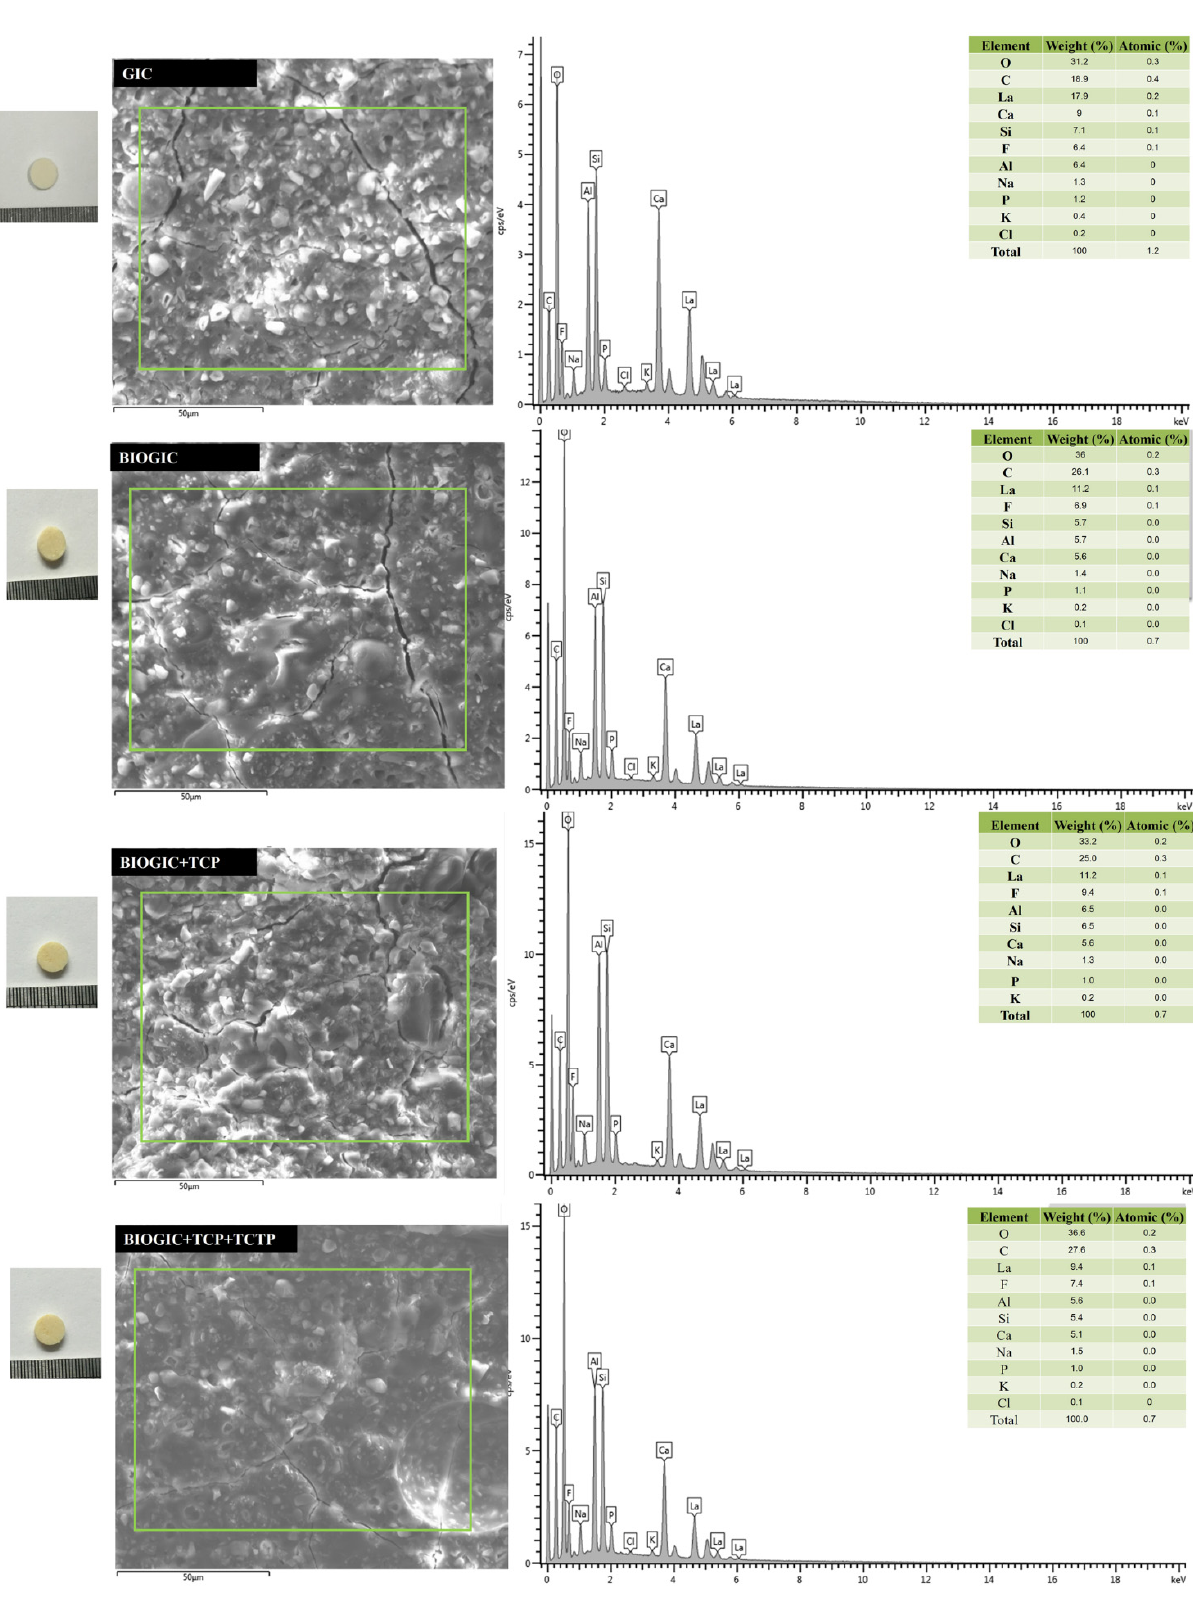
Figure 5. SEM-EDX spectrograms of GIC, BIOGIC, BIOGIC + TCP, and BIOGIC + TCP + TCTP found in the density fraction of b < 2.0 g cm − 3 (cts = counts).